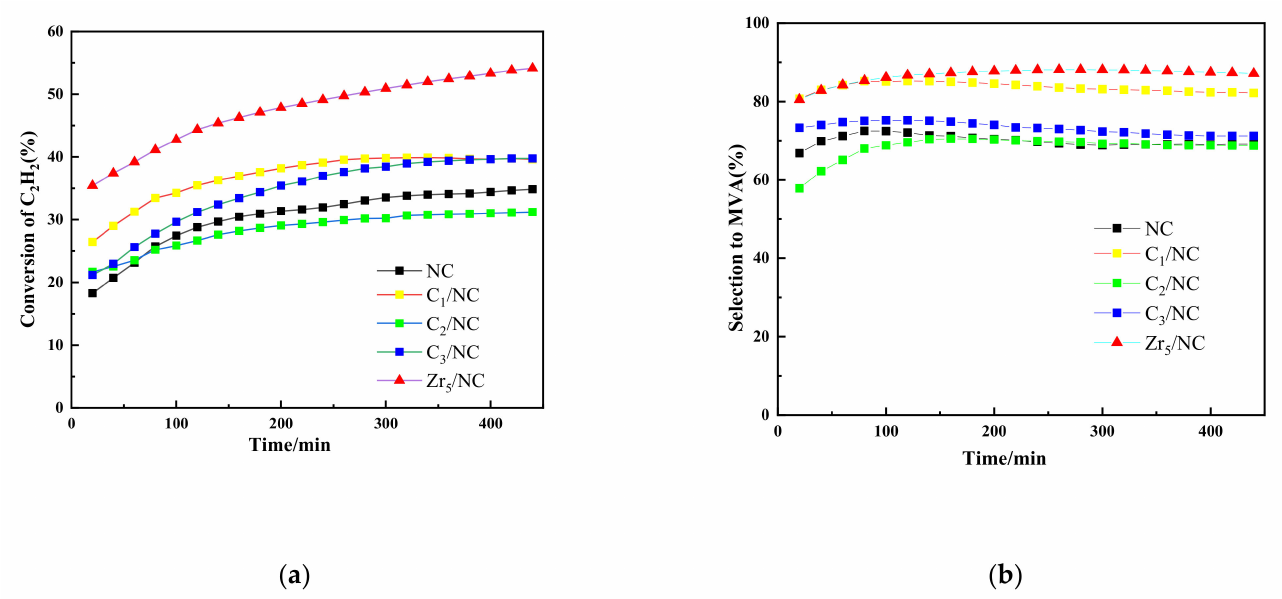
Figure 2. Catalytic performance of NC and C X /NC. ( a ) C 2 H 2 conversion with time on stream, and ( b ) MVA selectivity with time on stream. Reaction conditions; temperature (T) = 80 ◦ C, C 2 H 2 gas hourly space velocity (GHSV) = 110 h − 1